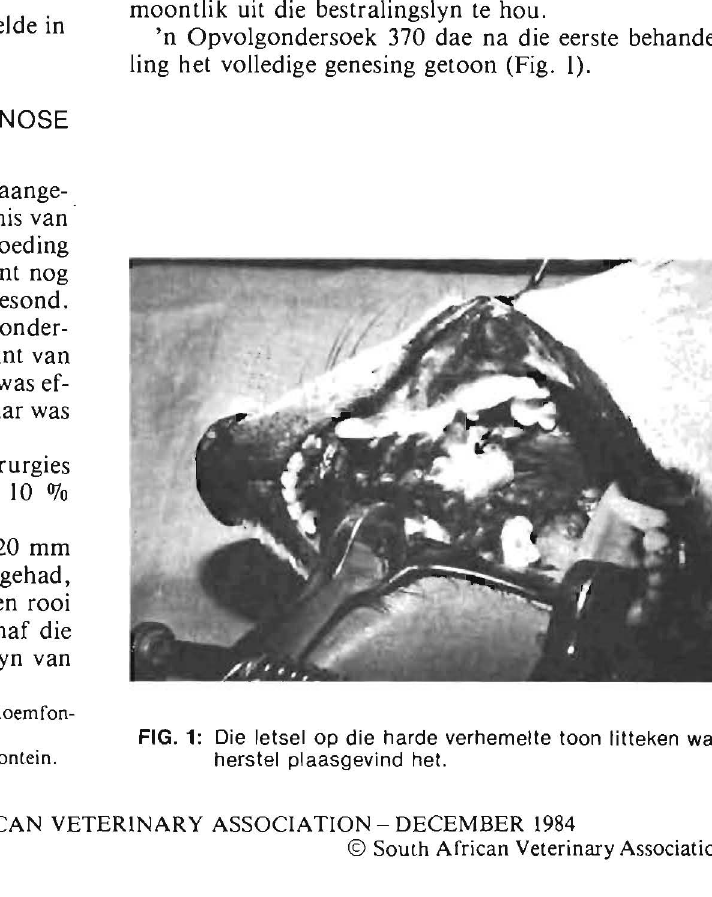
FIG. 1: Die lelsel op die harde verhemelle loon litteken waar herslel plaasgevind